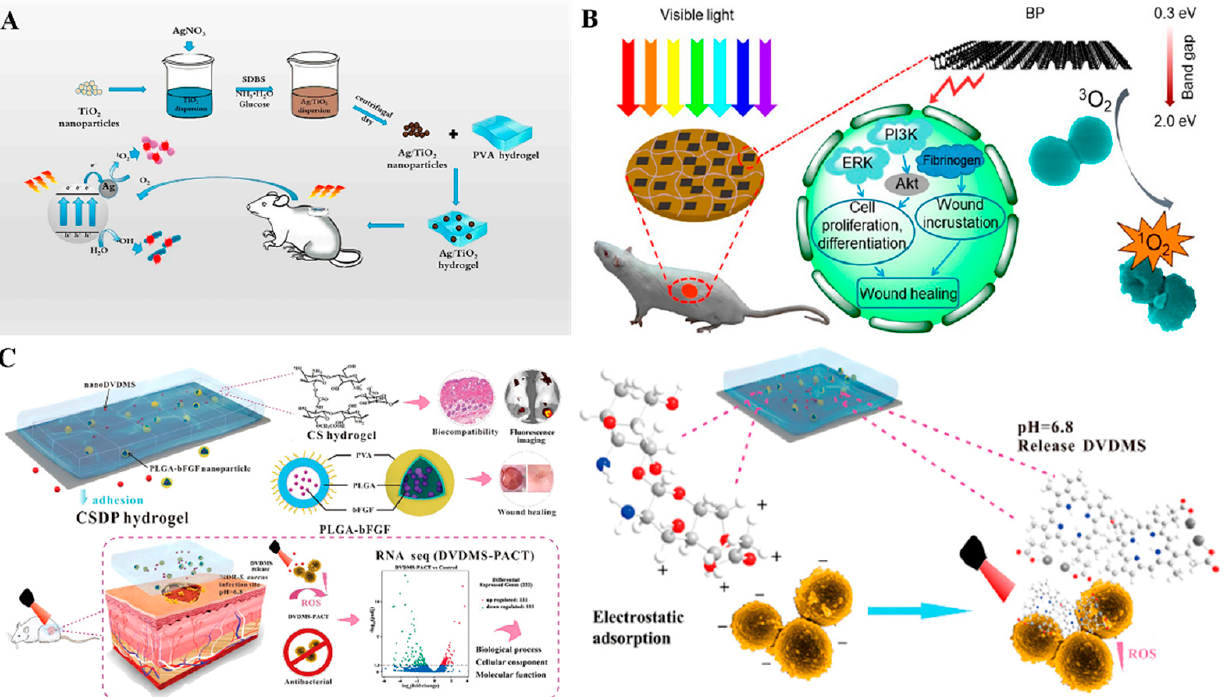
Figure 8. Nanocomposite hydrogel wound dressings with efficient photodynamic bactericidal performance in the treatment of infected wound. ( A ) The schematic illustration of the synthesis route of Ag/TiO 2 -incorporated polyvinyl alcohol hydrogel and its application in the prevention of bacterial infection during wound healing through the photodynamic antibacterial activity of TiO 2 upon visible irradiation at 606 nm. Reproduced with permission from ref [201], Copyright 2019 Elsevier. ( B ) A black phosphorus nanosheets (BPs)-embedded chitosan hybrid hydrogel (BP@CS) for visible light-triggered photodynamic therapy to accelerate bacteria-accompanied wound healing by BP- induced singlet oxygen ( 1 O 2 ) production and activation of signaling pathways. Reprinted from ref [200]. Copyright 2018 American Chemical Society. ( C ) Schematic illustration of a photosensitizer (DVDMS) loaded multifunctional hydrogel for synergizes bacterial clearance and skin regeneration of the infected burn wounds. Reprinted from ref [202]. Copyright 2020 American Chemical Society. bacterial growth, a high-temperature is required using PTT, which may damage